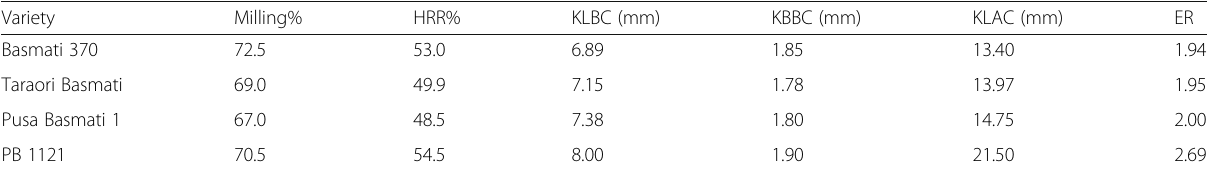
Table 1 Grain and cooking quality characteristics of improved Basmati rice variety PB 1121 compared to Basmati 370, Taraori Basmati and Pusa Basmati 1 Variety